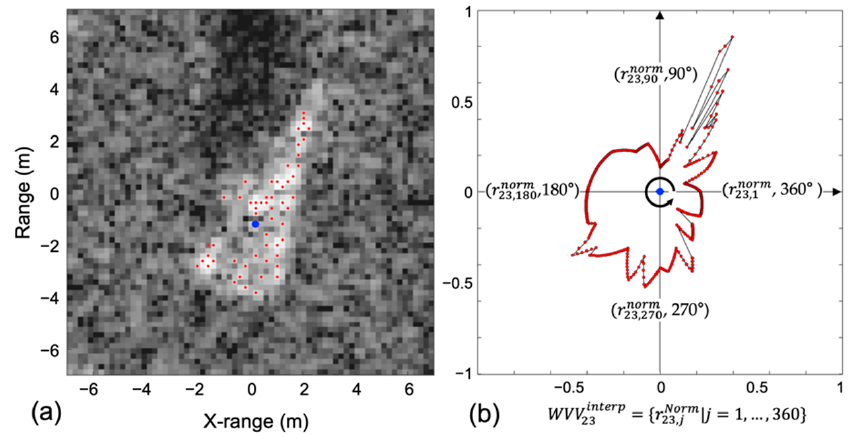
Figure 5. Example of WVV-based feature reconstruction using ASCs: ( a ) 56-ASC set and ( b ) interpolated 23rd WVV.